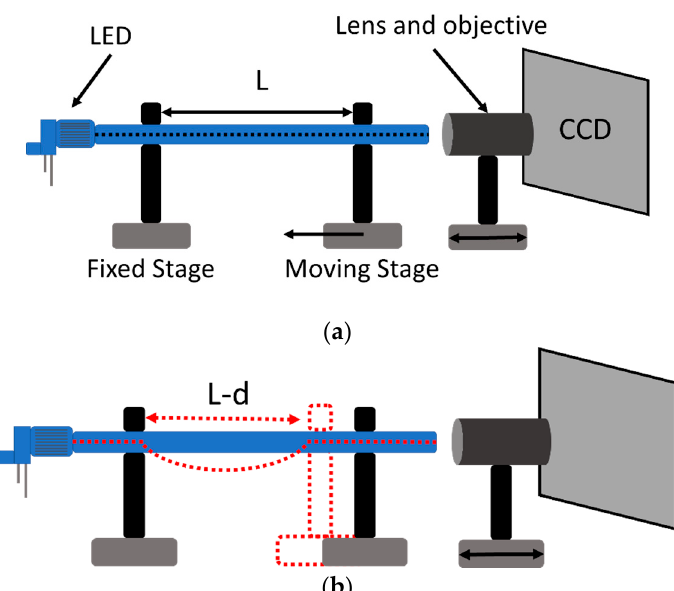
Figure 4. Schematic representation of the experimental setup ( a ) and method used to obtain constant curvature ( b ).